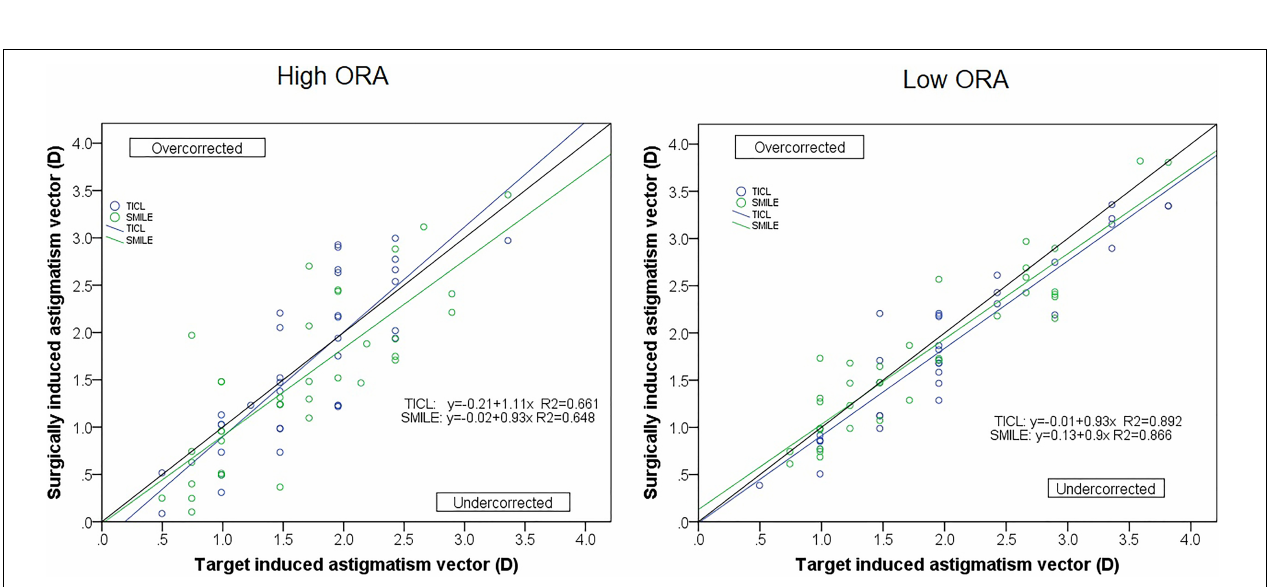
FIGURE 5 | Target-induced astigmatism vector (TIA) plotted against surgical-induced astigmatism vector (SIA) for small incision lenticule extraction (SMILE) and toric implantable Collamer lens (TICL) implantation (Visian Implantable Collamer Lens; STAAR Surgical, Monrovia, CA, United States) for the high and low ORA groups.